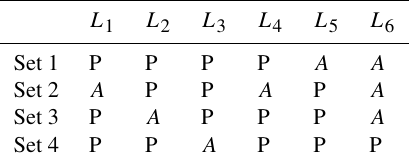
Table 1. L 1 – L 6 are different locations. Sets 1–4 describe a dis- charge event. Generally, dynamic discharge events do not occur at all locations, such that peaks (P) cannot be identified for all loca- tions. Therefore, auxiliary values ( A ) have to be used to fill in the gaps.